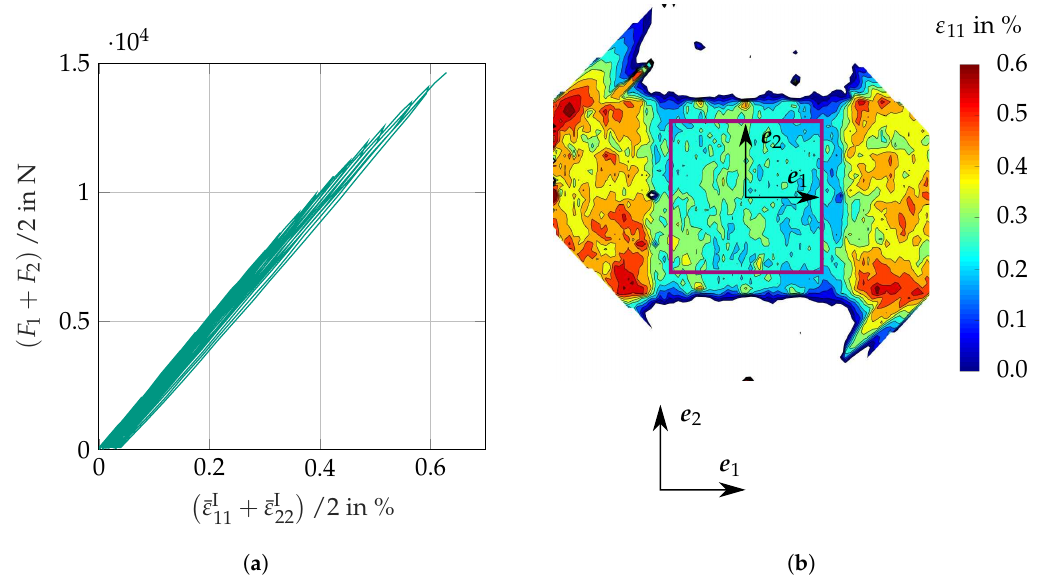
Figure 6. Unreinforced specimen arms with loading scenario P Γ = 1 . ( a ) Force over strain, average values over the e 1 - and the e 2 -direction; ( b ) Contour plot of the normal strain ε 11 at ¯ ε I